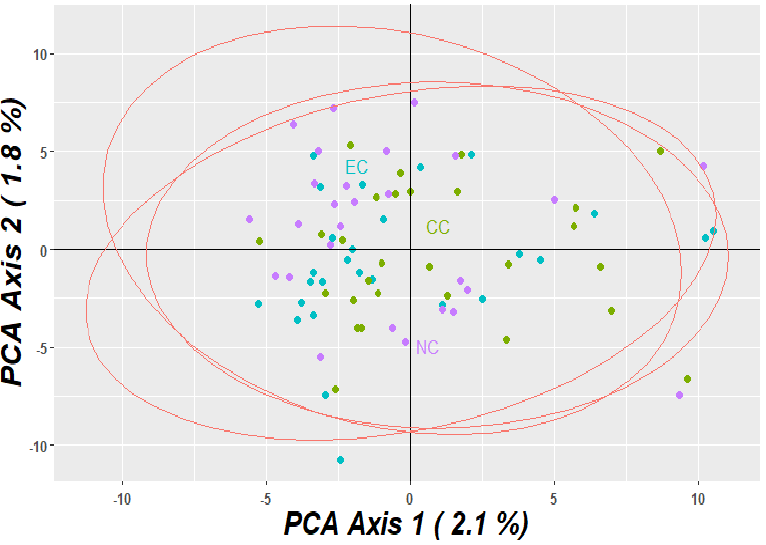
Figure 5. Principal component analysis (PCA) based on 7681 SNPs. CC: central Croatia, NC: north Croatia, and EC: east Croatia.